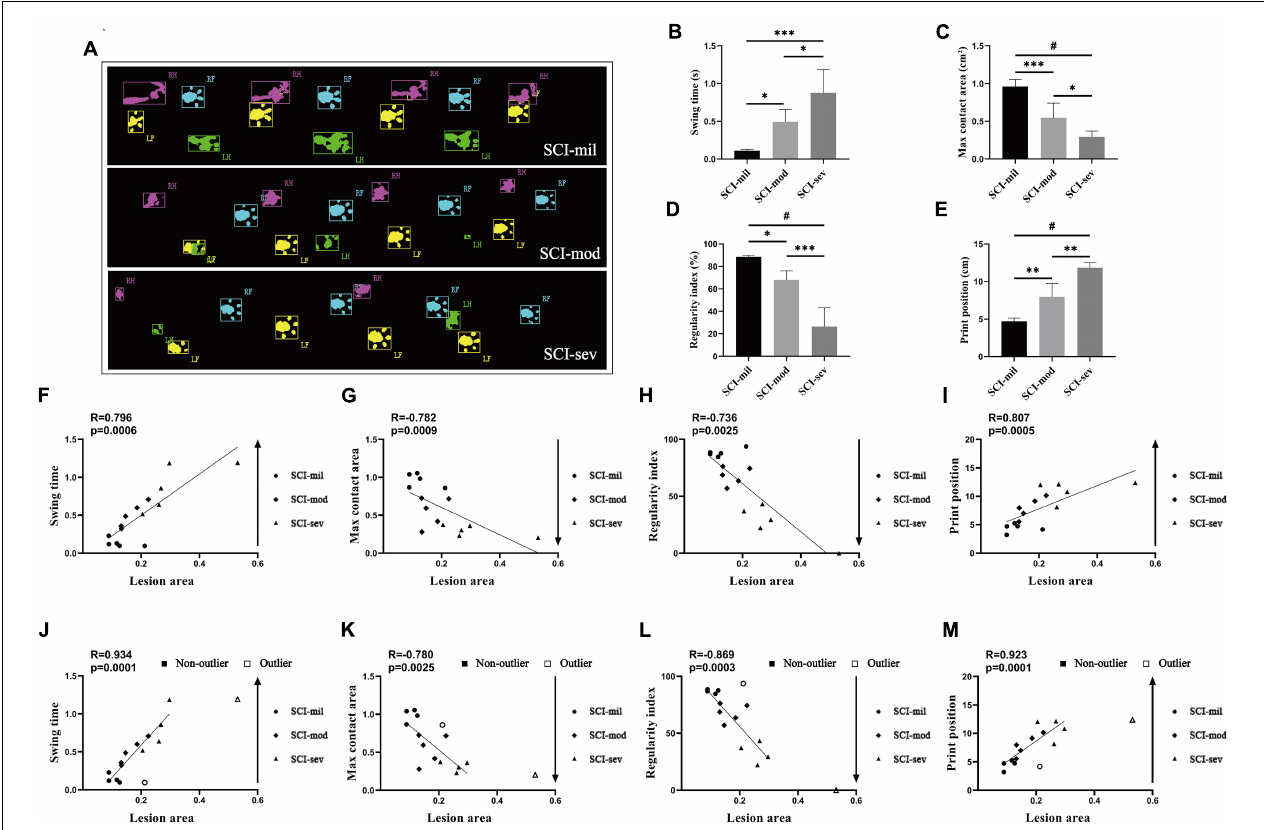
FIGURE 4 | Catwalk test and Spearman’s rank correlation coefficient test. (A) Photographs of catwalk test in three groups. Various levels of spontaneous recovery, comparison among three groups on (B) swing time, (C) max contact area, (D) regularity index, and (E) print position, were evaluated by the catwalk test in rats that underwent contusion of three different severities. n = 5 per group ( ∗ p < 0.05; ∗∗ p < 0.01; ∗∗∗ p < 0.001; # p < 0.0001; ns represents no statistical significance). (F–I) Correlation analysis between lesion area and indicators of the catwalk including outliers. (H–J) Correlation analysis between lesion area and indicators of catwalk after removing outliers.